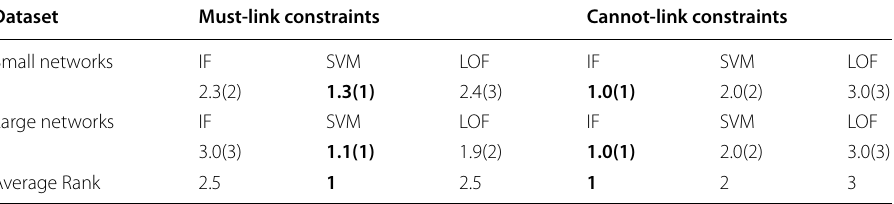
Table 7 Average ranks of Isolation Forest (IF), One-class SVM, and Local Outlier Factor (LOF) over all small and large LFR networks, for must-link and cannot-link constraints